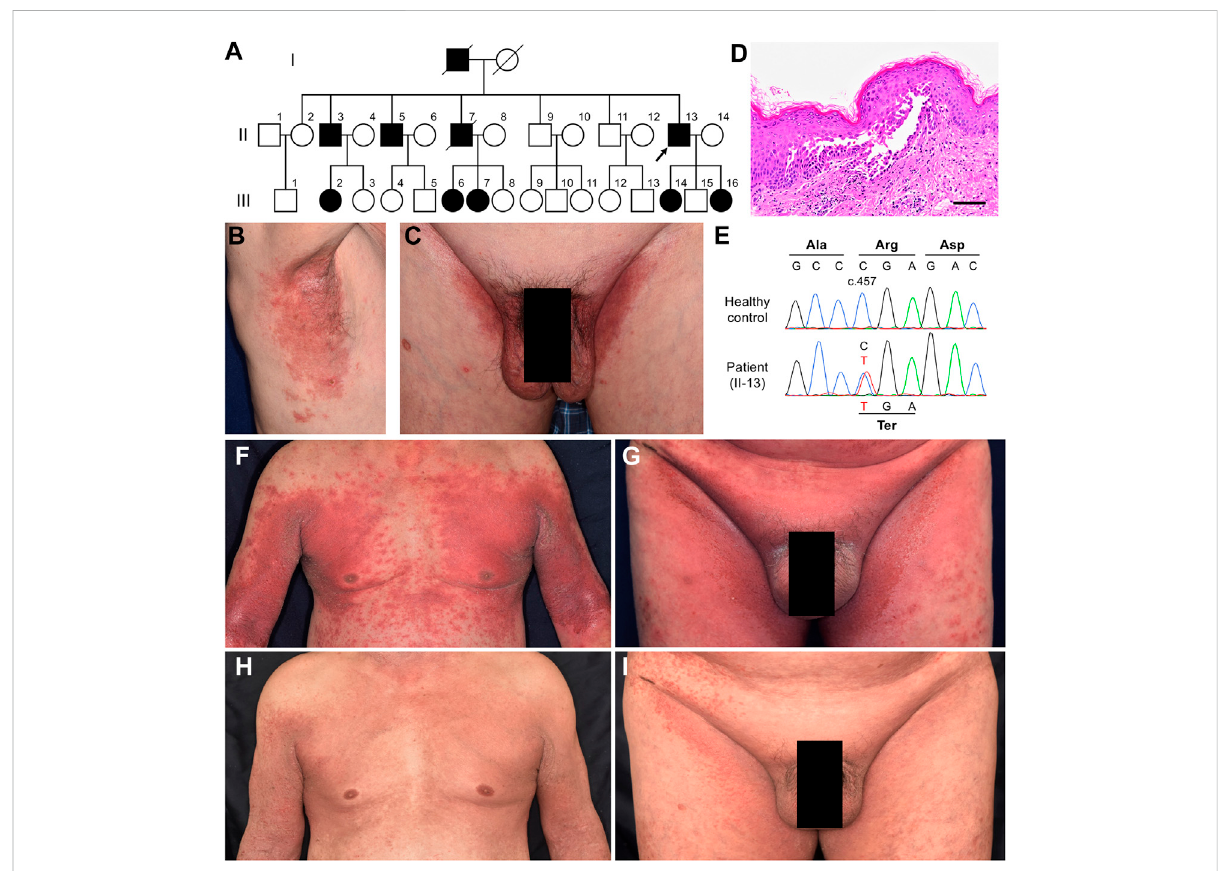
FIGURE 1 Clinical, histological, and genetic features of Case 1. (A) Pedigree of the family with HHD. Affected individuals are represented by a solid square or circle, depending upon the gender, and the proband (the present case) is indicated by an arrow. (B, C) Clinical fi ndings at the fi rst visit to our hospital. (D) Pathologicalfeaturesofthelesionontherightaxilla.Hematoxylinandeosinstaining(scalebars,100 μ m). (E) Thepatientisheterozygous for a nonsense mutation (C) c.457C > T (p. Arg153Ter) in ATP2C1 . (F, G) The most severe state, at the third hospitalization. (H, I) Clinical improvement after a month of treatment with apremilast following the initial 2-week treatment with oral